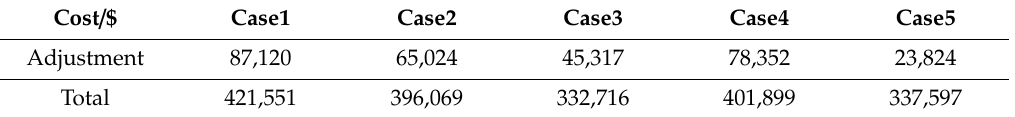
Table 5. System optimal scheduling with an uncertainty of 30%.